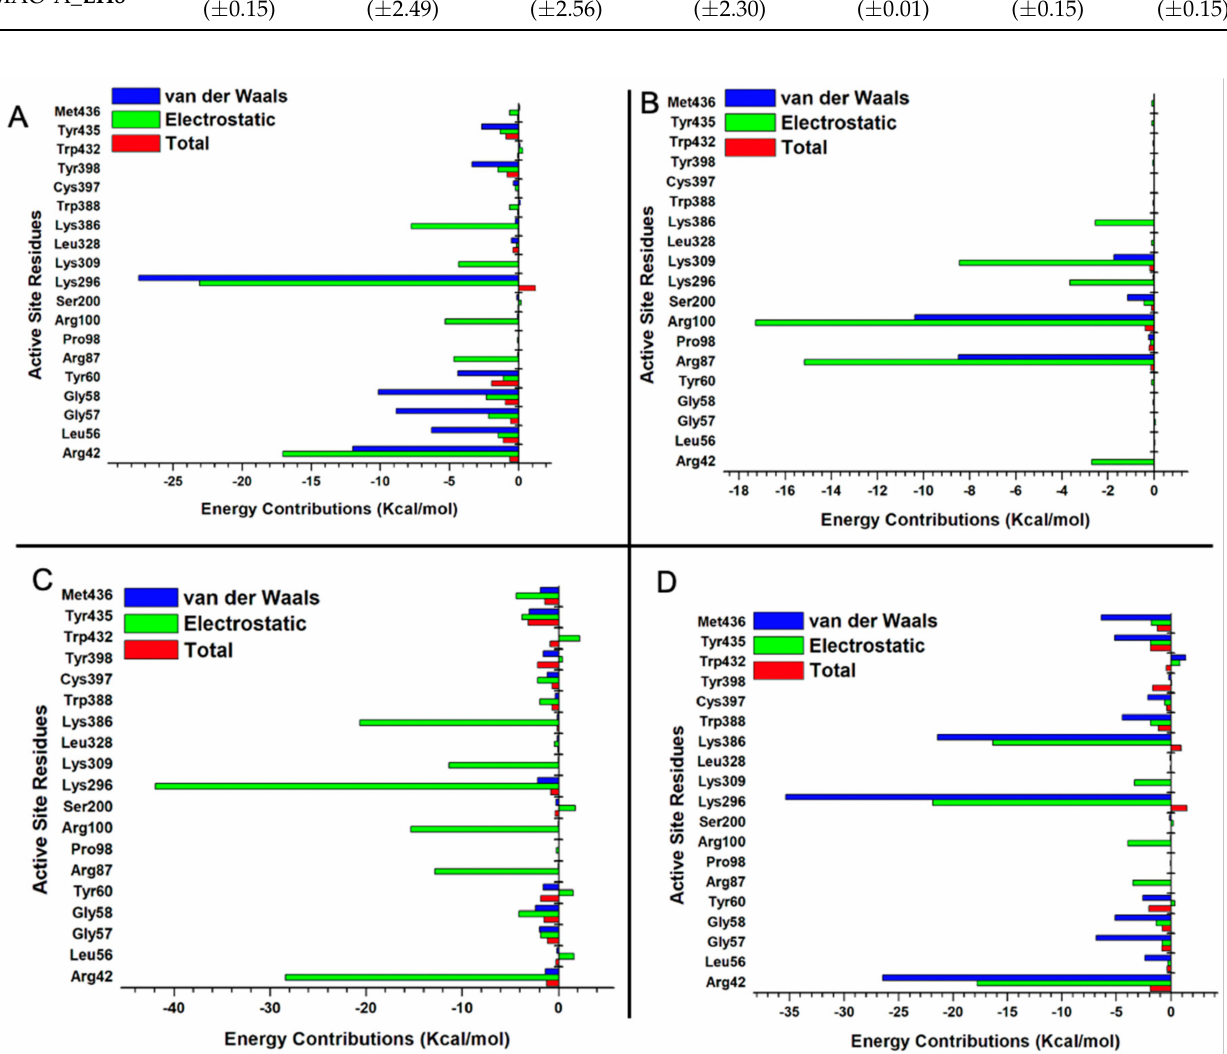
Figure 8. Per residue decomposition of EH1 bound to MAO-B ( A ), EH6 bound to MAO-B ( B ), EH7 bound to MAO-B ( C ), and EH8 bound to MAO-B ( D )